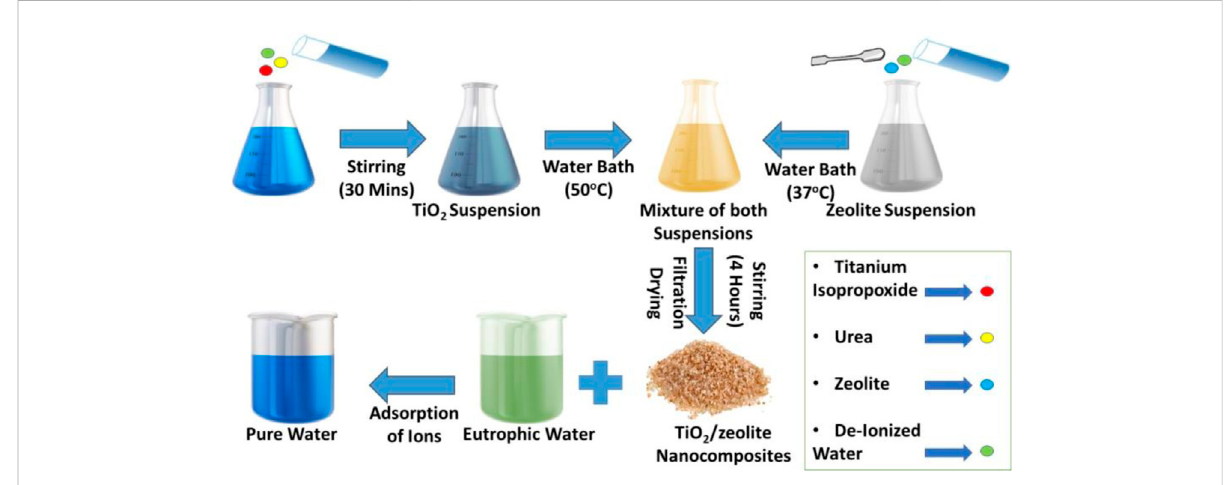
The mechanism for the synthesis of TiO 2 /zeolite nanocomposites and their role in the adsorption of